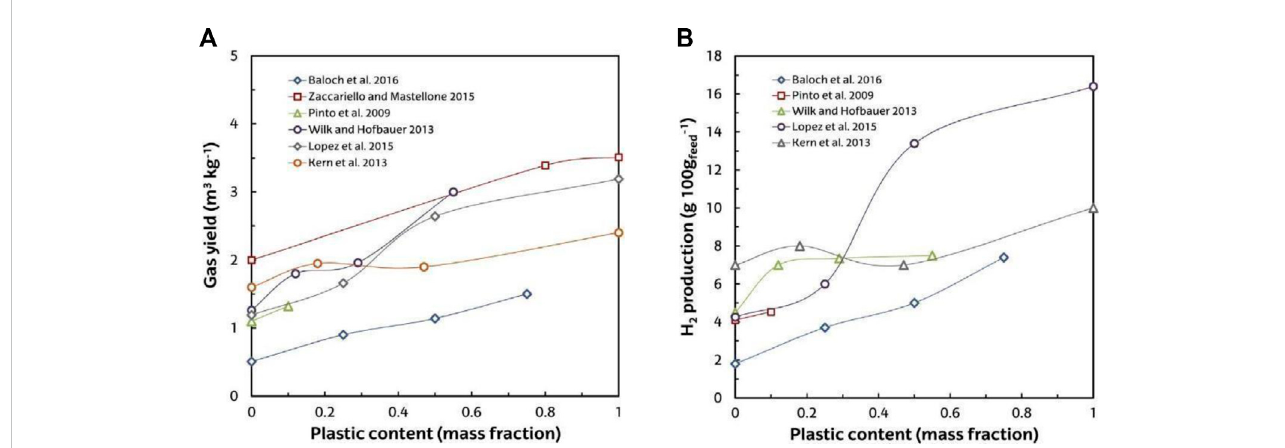
FIGURE 9 (A) The effect of the feed ’ s plastic content on the yields of gas in plastics co-gasi fi cation with coal and biomass. (B) Plastic content effect in the feed on the production of H